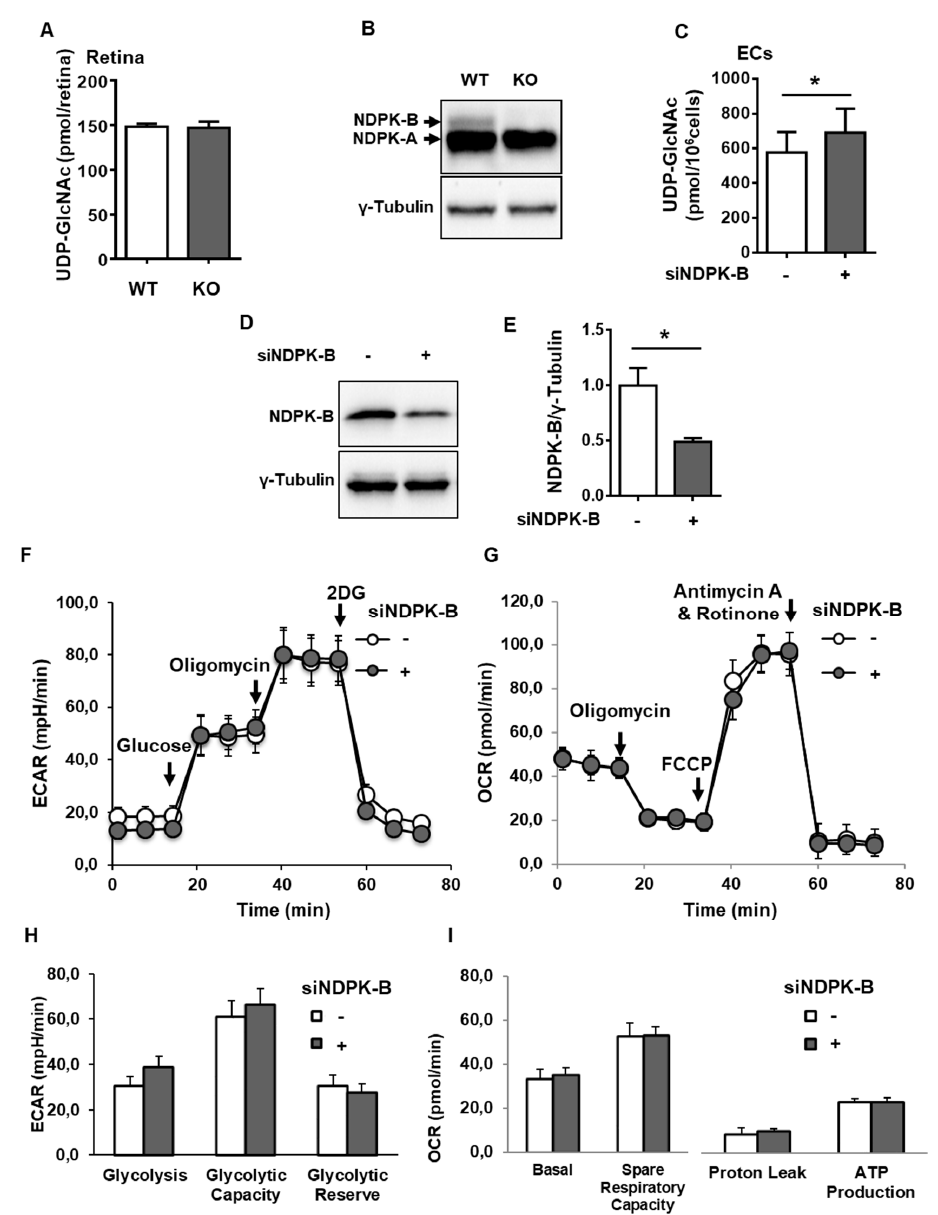
Figure 1. Loss of nucleoside diphosphate kinase B (NDPK-B) in endothelial cells (ECs) causes an activation of the hexosamine biosynthesis pathway (HBP). UDP-GlcNAc was quantified by UPLC-PDA in ( A )